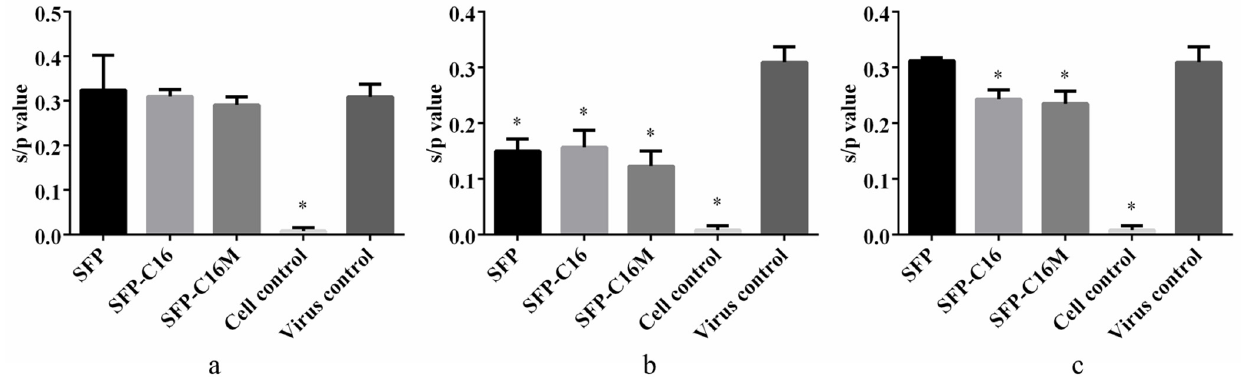
Figure 7. ALV-J p27 antigen expression after different administrations. The results are the means ± SD ( n = 3); * p < 0.05 compared with the virus control. ( a ) BA (before adsorption) administration; ( b ) Ad (adsorption) administration; ( c ) AD (after adsorption) administration.